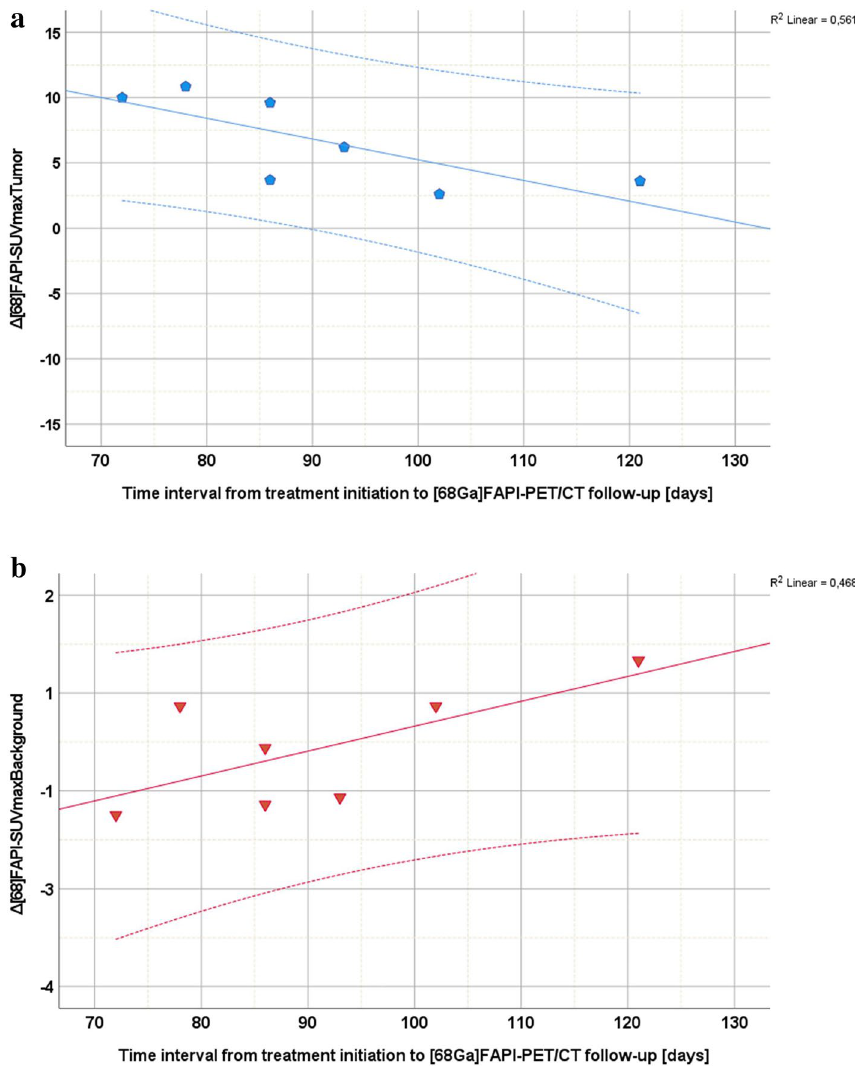
Figure 6. ( a ) Distribution plot highlighting absolute difference of [ 68 Ga]FAPI-uptake for index lesions (blue spheres) (ΔSUV maxTumor ) examined on timepoint t 1 and timepoint t 2 . Absolute difference of tumoral uptake on follow-up PET-images declines. Scatter graphs considering the 7 patients undergoing radiation therapy with SUV max decrease of index lesions from timepoint t 1 to timepoint t 2 . ( b ) Distribution plot highlighting absolute difference of [ 68 Ga]FAPI-uptake for perilesional background (red triangles) (ΔSUV maxBackground ) examined on timepoint t 1 and timepoint t 2 . Absolute difference of perilesional uptake on follow-up PET-images rises. Scatter graphs considering the 7 patients undergoing radiation therapy with SUV max decrease of index lesions from timepoint t 1 to timepoint t 2